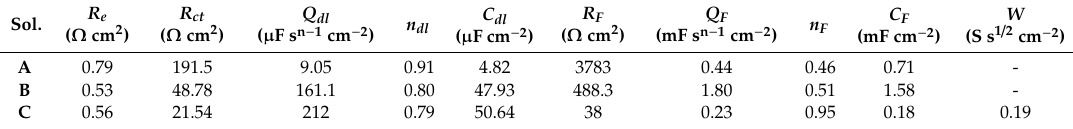
Table 2. Electrochemical parameters of Cu dissolution in di ff erent bromide-containing systems.